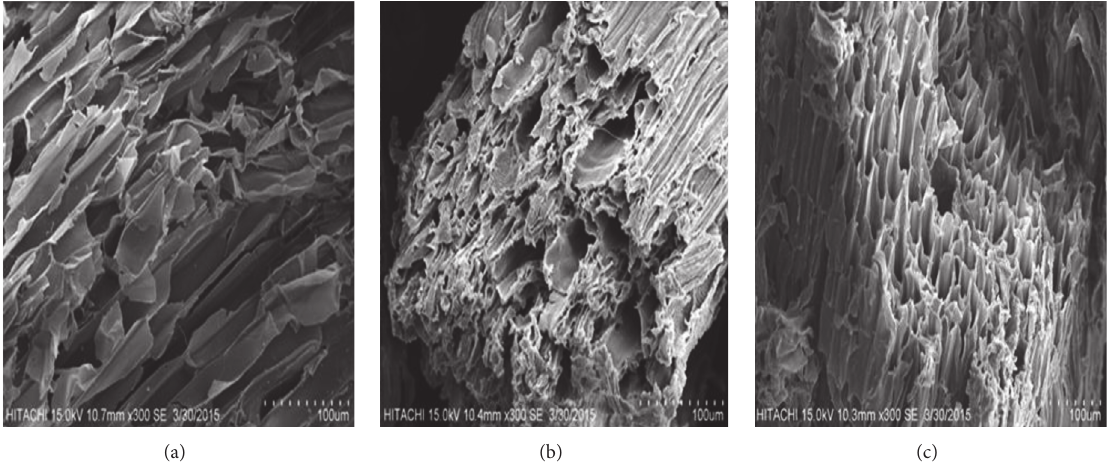
Figure 4: SEM images: (a) natural KCF, (b) mercerization KCF, and (c) quaternization KCF.